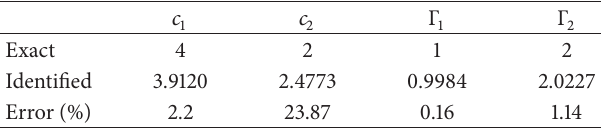
Table 3: Identified coefficients compared with the exact ones: (𝑡